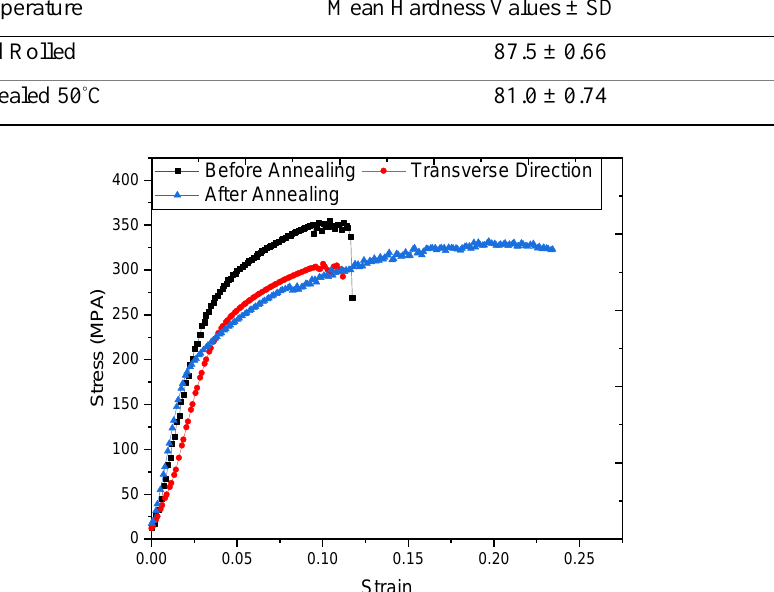
Table 5. Vickers Hardness Value.